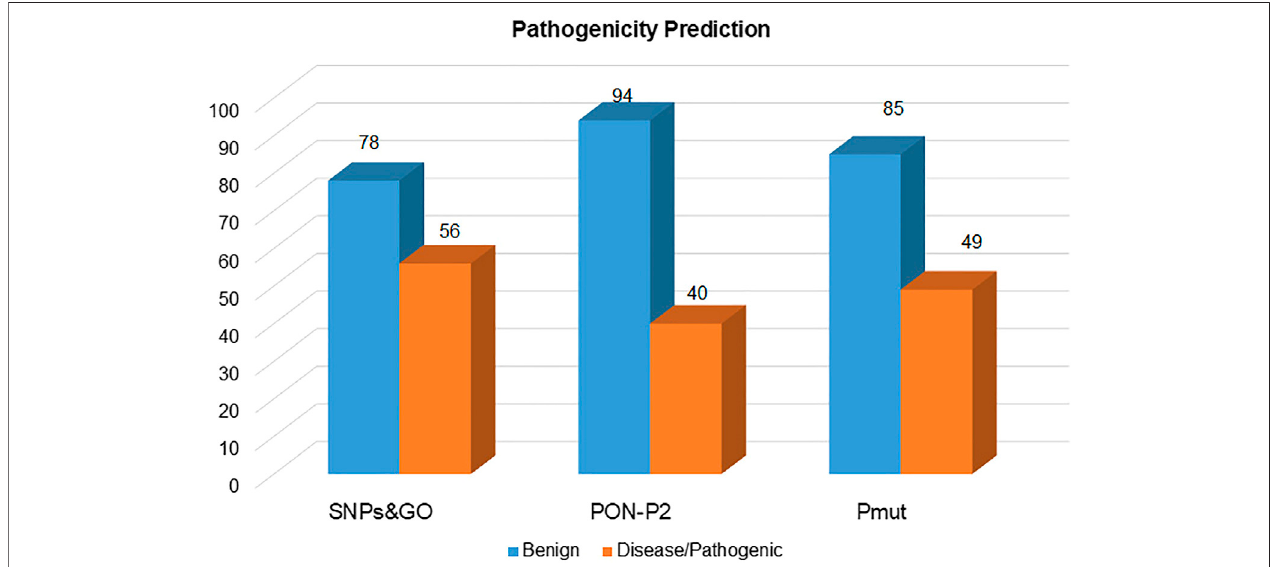
FIGURE 4 | Pathogenic mutations in the SGK1 protein, identi fi ed using SNPs and GO, PON-P2, and PMut.